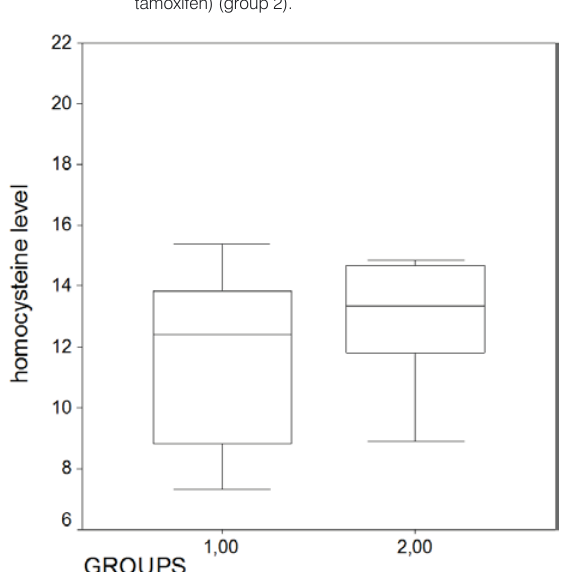
Figure 1. Serum homocysteine levels in control subjects (group 1) and breast cancer patients (at baseline value before tamoxifen) (group